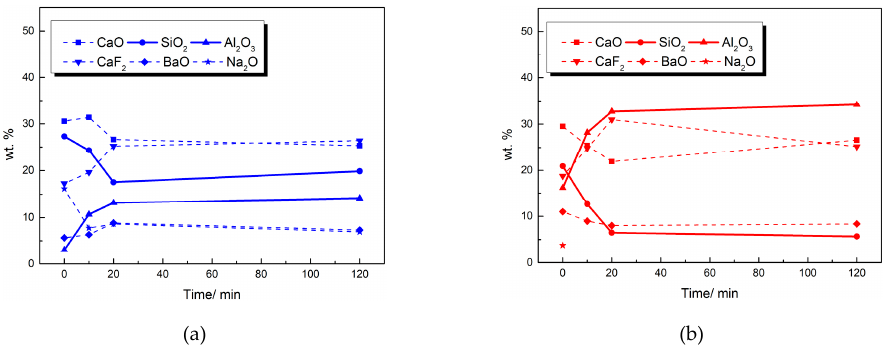
Figure 2. Variation of main compositions for slag sample: ( a ) Sample A; ( b ) sample B.